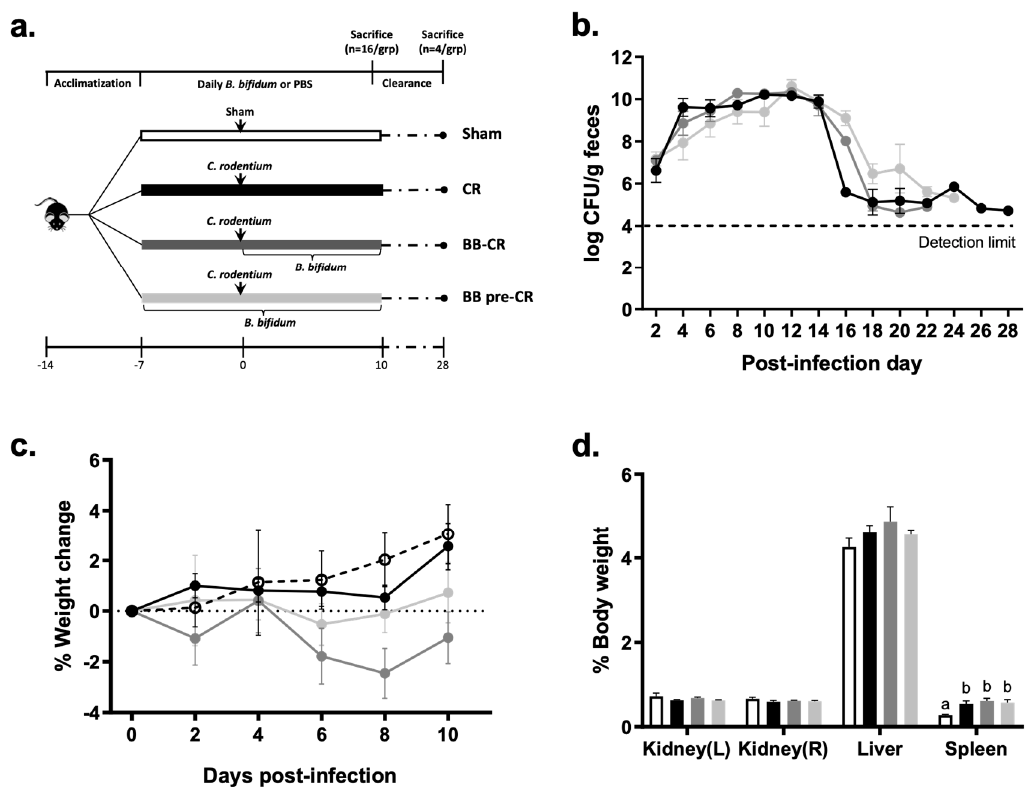
Figure 1. Study design and C. rodentium infection model ( a ) study design; ( b ) viable C. rodentium counts in infected mice feces were quantified every other day p.i., n = 9–13/group (day 2–10 p.i.), and n = 1–4/group (day 12–28 p.i.); ( c ) percentage of body weight change among groups after infection, n = 12/group; ( d ) percentage of organ weight per gram of body weight among Sham and infected groups on day 10 p.i., n = 8/group. Data are presented as mean ± SE. Statistical significance was determined by repeated-measures ANOVA for C. rodentium counts and weight change and one-way ANOVA for organ weight followed by Bonferroni’s post-hoc test. Different superscripts (a,b) indicate significance among groups, p < 0.05. ( ○ ) Sham, ( ● ) CR, ( ● ) BB-CR, ( ● ) BB pre-CR.